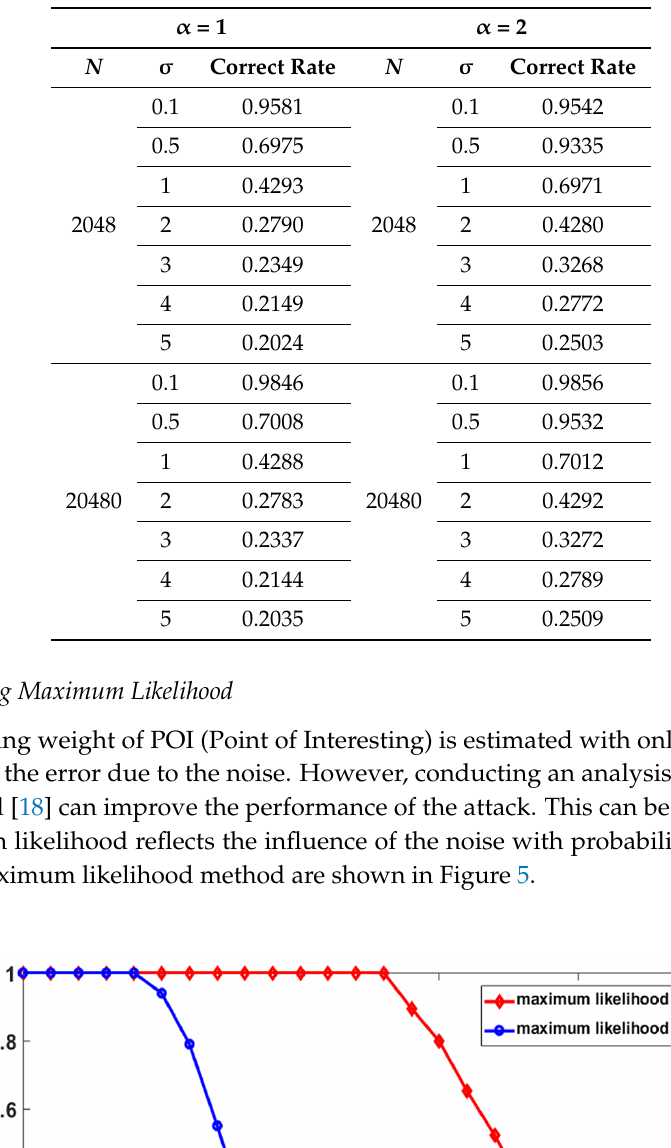
Table 1. Performance of slice method.